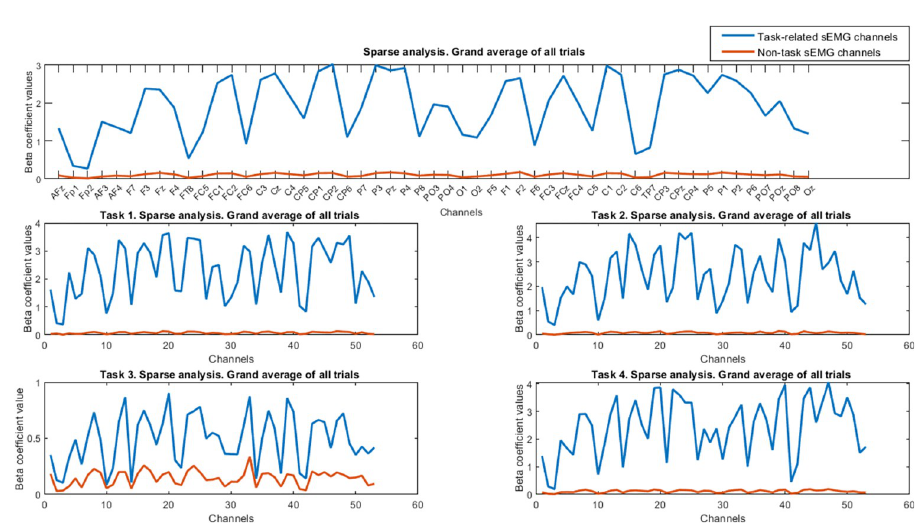
Fig 6. Grand average of sparse analysis results for all trials. The stronger coupling values for task-related sEMG channels are observable for all trials and also in all trials of each task. Row 1 shows the results for total trials. Rows 2 and 3, respectively show the results of all trials for each task. The legend for all subplots is the same as row 1.